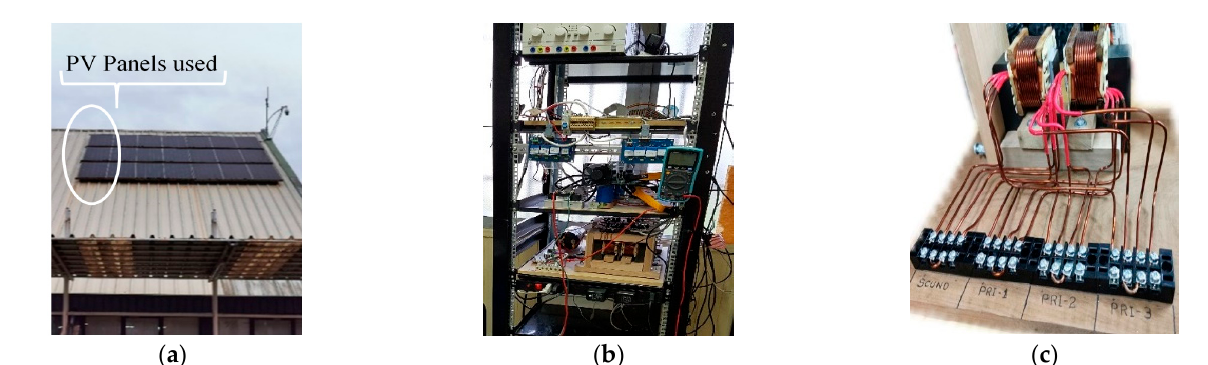
Figure 17. ( a ) PV panels used to test the converter. ( b ) Laboratory experimental setup. ( c ) Flyback transformer built with three primary winding and three secondary windings.